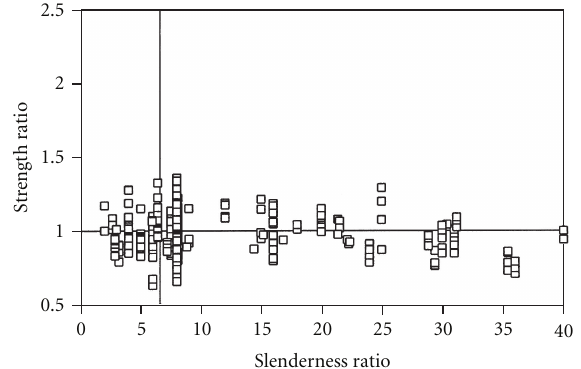
Figure 9: E ff ect of longitudinal reinforcing steel index ρ rs f yrs / f (cid:2) c on FEM strength ratios for reinforced concrete columns ( n = 354).